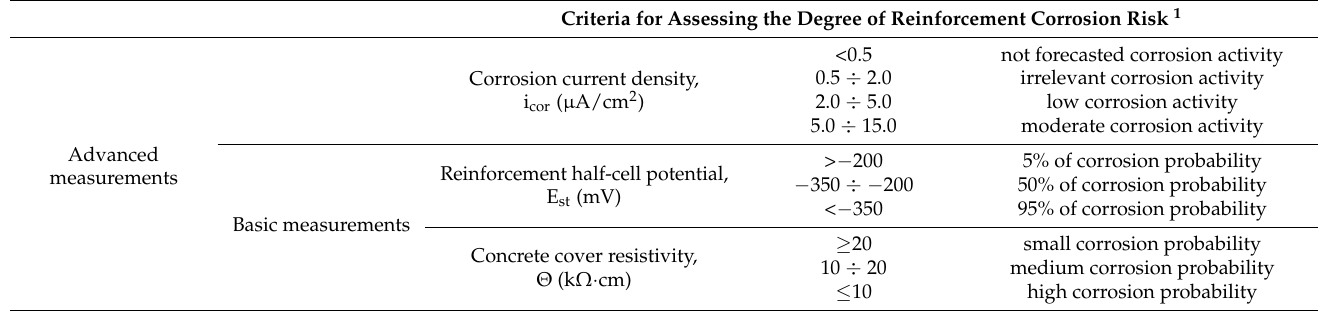
Table 2. Criteria for assessing the degree of reinforcement corrosion